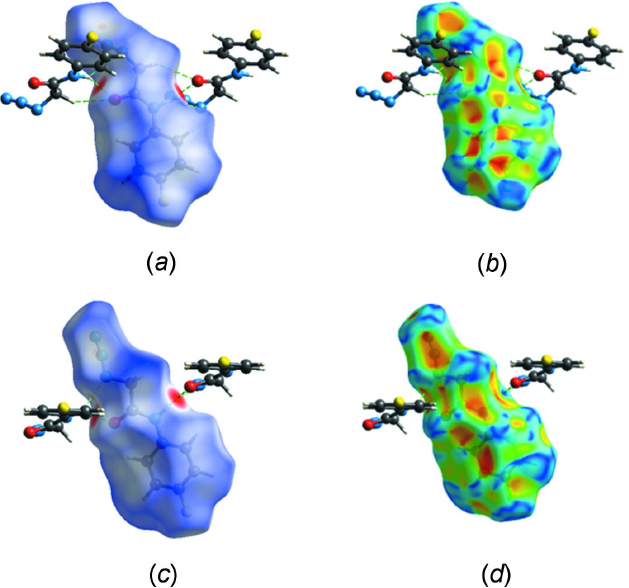
Figure 5 The ( a ) d norm and ( b ) shape-index surfaces for the molecule containing O1, and the ( c ) d norm and ( d ) shape-index surfaces for the molecule containing O2 together with the two closest molecules of each